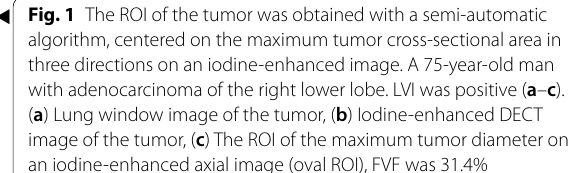
Fig. 1 The ROI of the tumor was obtained with a semi-automatic algorithm, centered on the maximum tumor cross-sectional area in three directions on an iodine-enhanced image. A 75-year-old man with adenocarcinoma of the right lower lobe. LVI was positive ( a – c ). ( a ) Lung window image of the tumor, ( b ) Iodine-enhanced DECT image of the tumor, ( c ) The ROI of the maximum tumor diameter on an iodine-enhanced axial image (oval ROI), FVF was 31.4%